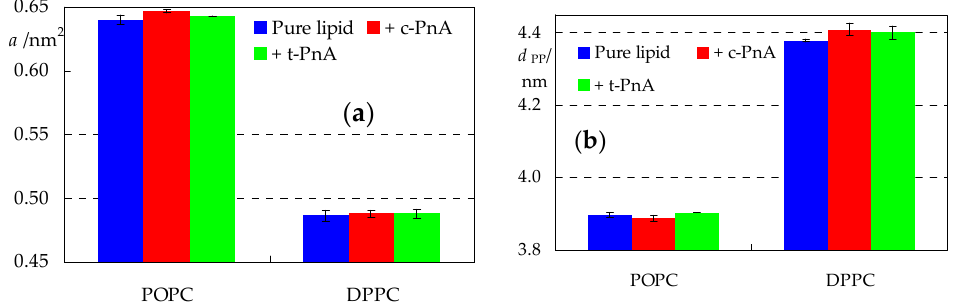
Figure 3. Average area per lipid molecule a ( a ) and bilayer thickness (evaluated as the distance between the average planes of the lipid P atoms in opposite leaflets, d PP ; ( b )) for the studied systems.